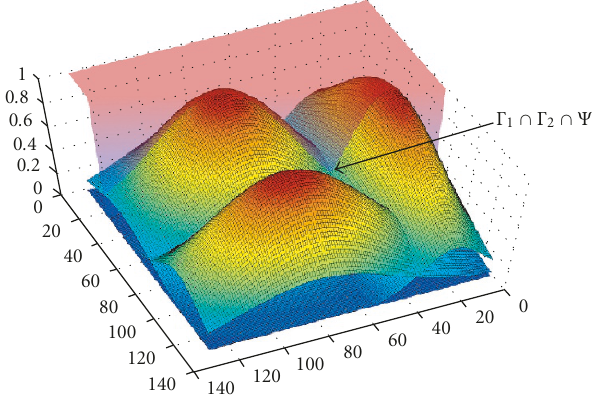
Figure 6: Locating the cropping points at intersection of two Gaus- sian surfaces Γ 1 and Γ 2 and the Ψ plane defined by two center points ( μ x 1 , μ y 1 ) and ( μ x 2 , μ y 2 ).